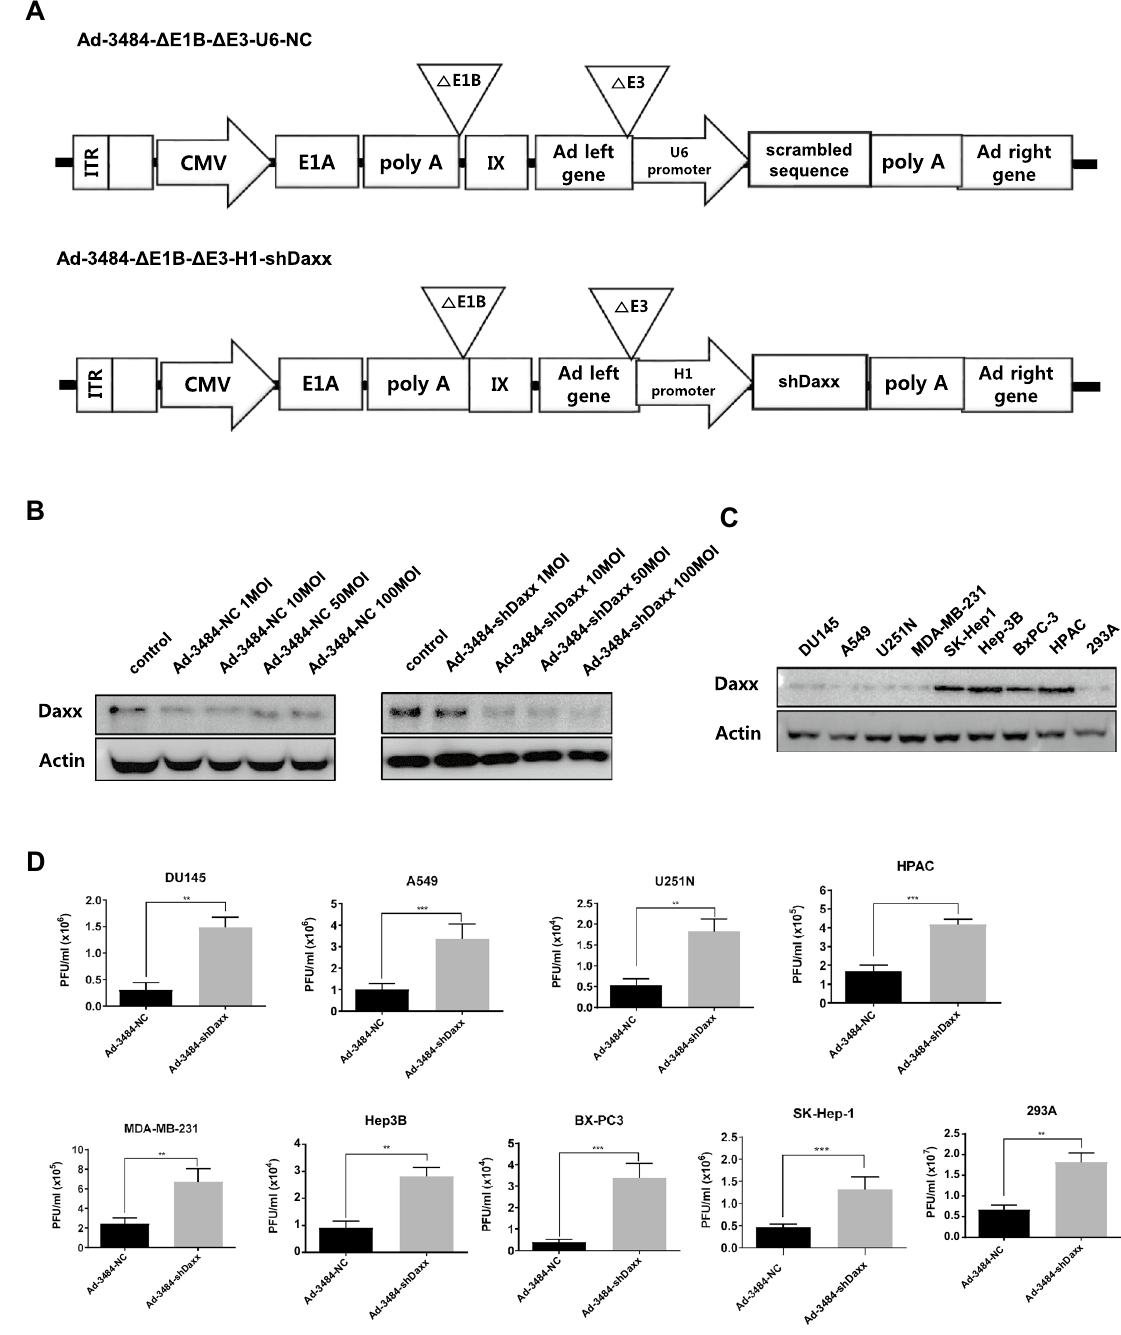
Figure 1. Enhanced adenovirus production by oncolytic adenovirus armed with Daxx shRNA. ( A ) Scheme of E1B55K-deleted oncolytic adenovirus armed with scrambled RNA (Ad-3484-NC) or Daxx shRNA (Ad-3484-shDaxx). ( B ) Expression of Daxx protein after infection with Ad-3484-NC or Ad-3484-shDaxx at the indicated MOIs for 48 h in DU145 cells. ( C ) Endogenous Daxx protein levels in various human cancer cells. ( D ) Plaque-forming unit (PFU) titration assays of adenovirus produced by each human cancer cell line following Ad-3484-NC or Ad-3484-shDaxx infection at MOI 50 for 48 h with exchanged media after PBS washing. Error bars represent standard errors from three independent experiments. P values less than 0.05 were considered statistically significant (* P < 0.05; ** P < 0.01; *** P < 0.001). ( E ) Crystal violet oncolytic assay of DU145 (left), U251N (middle), and A549 cells (right) following Ad-NC, Ad-shDaxx, Ad-3484-NC, or Ad-3484-shDaxx infections at MOIs between 0 and 10 for 72 h. All cells remaining on plates were fixed with 4% paraformaldehyde and stained with 0.05% crystal